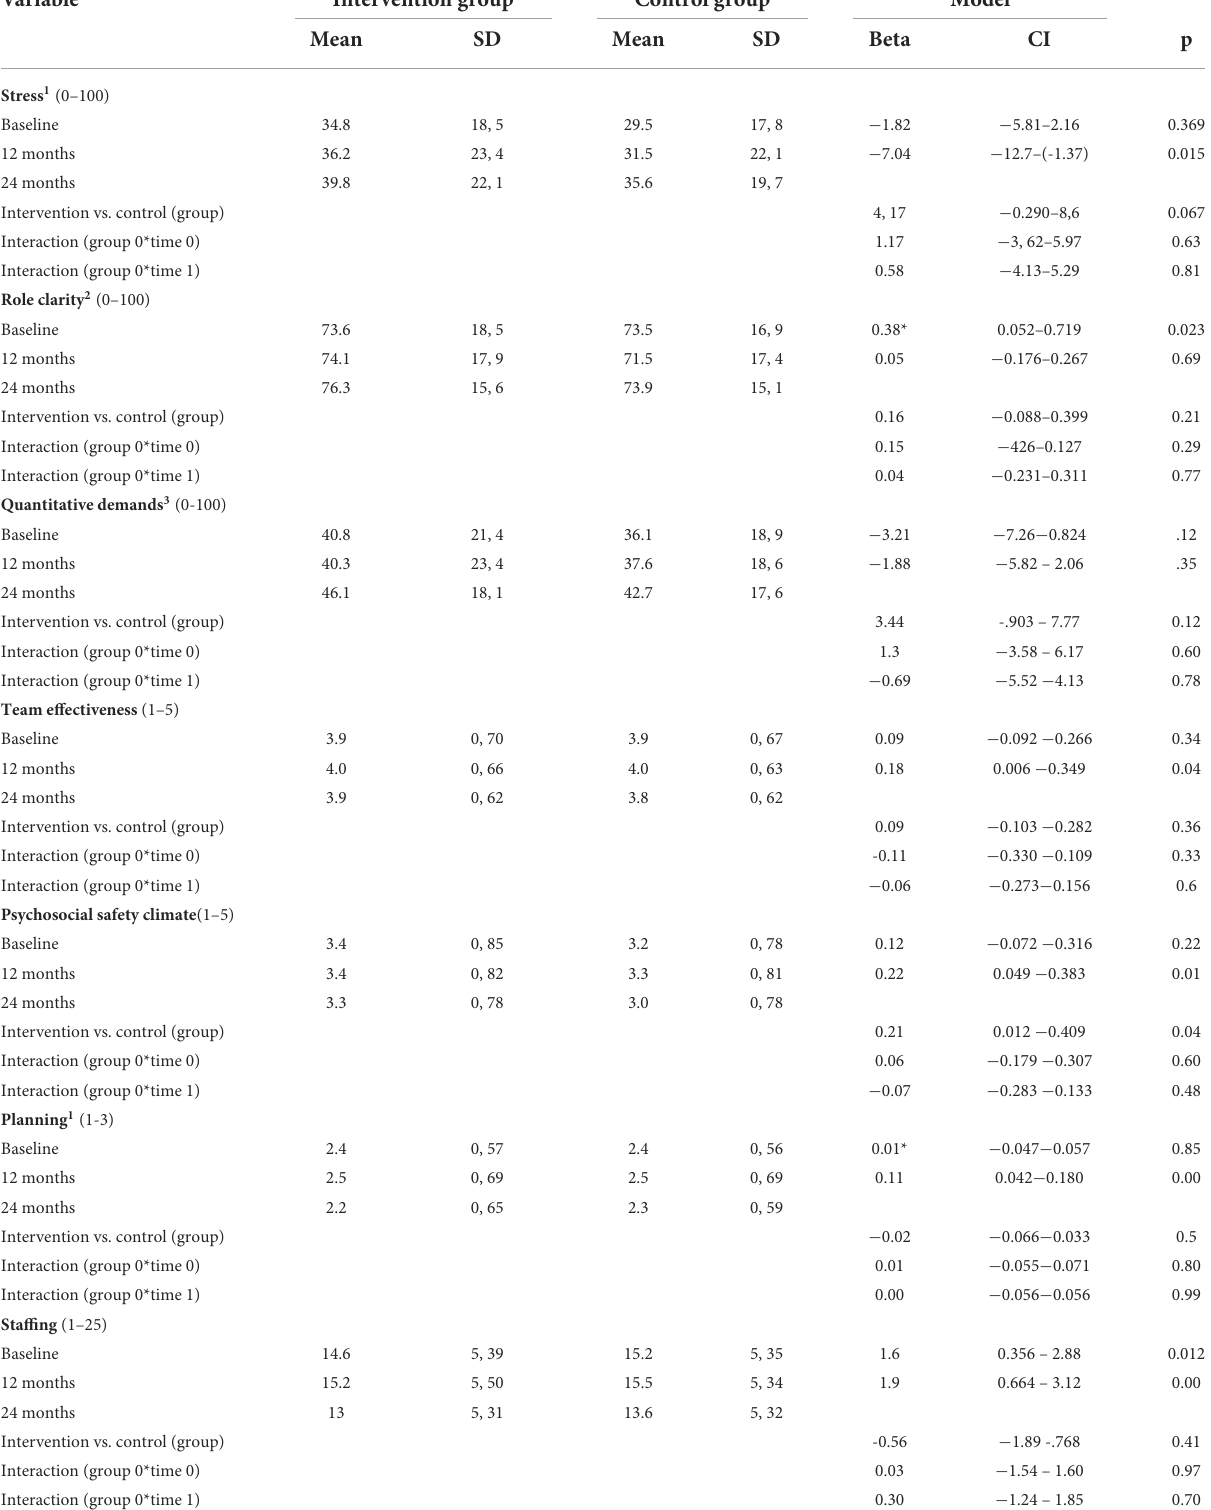
TABLE 2 Adjusted mean values and standard deviations (SD) at all time points for the intervention and control groups. Variable Intervention group Control group